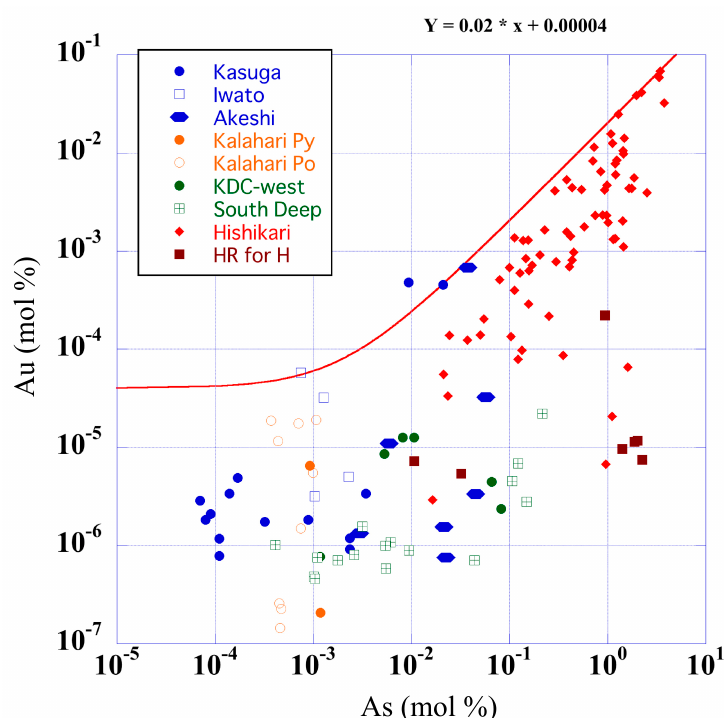
Figure 9. Log–log plot of the relationship between the Au and As concentrations (mol%), including all the SIMS data for the pyrite and pyrrhotite. The Au–As relationship in pyrite from the Hishikari deposit [20] is included for reference. The solid line represents the empirical solubility limit of Au in pyrite as a function of As concentration [18]. The labels ‘Hishikari’ and ‘HR for H’ represent pyrite grains in ore veins and host rocks, respectively, from the Hishikari deposit.